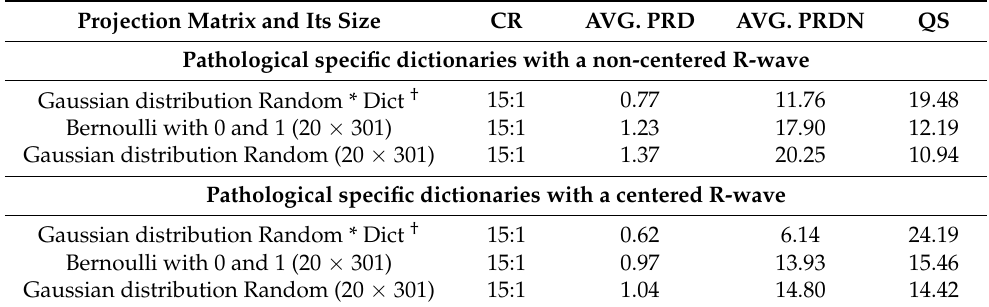
Table 5. Average results for 24 ECG records for CSCP method with a specific dictionary and classifi- cation based on the largest coefficient of the sparsest decomposition for the